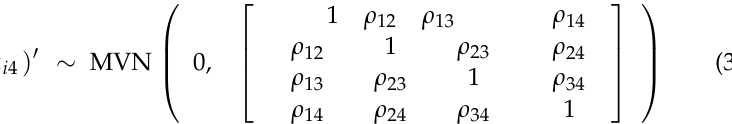
Table 3. Adoption rates of four agricultural machinery technologies in six agroecological maize regions and the overall adoption rates (%). Adoption Rates of Machinery Technologies in Six Agroecological Maize Regions Southwest Northeast North Yellow-Huai River Valley Northwest South Mechanical